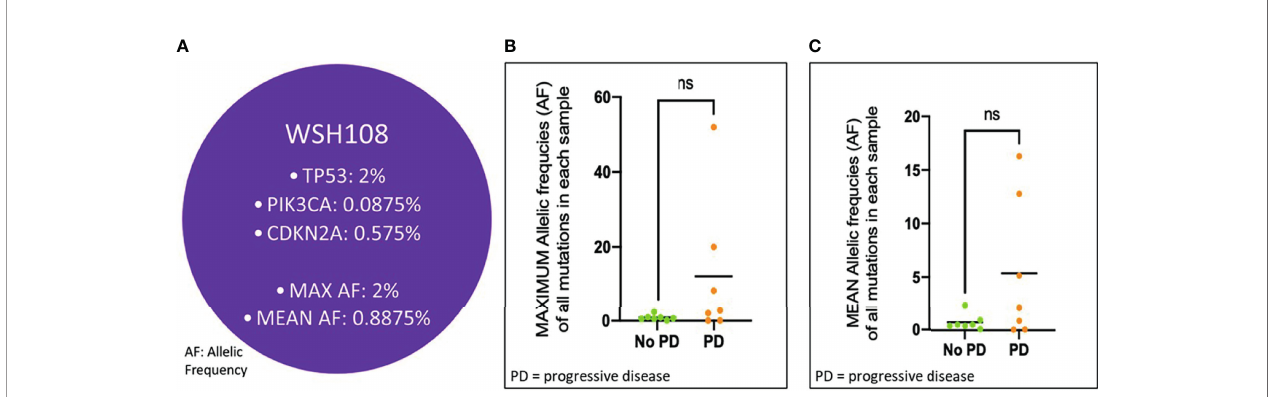
FIGURE 5 | Mean and Max Allelic Frequency in Patients at CRT initiation who Cleared ctDNA, Strati fi ed by Progression. (A) Schematic representation of a patient ’ s (WSH108) pre-CRT sample. Allelic frequency (AF) for each mutation detected in the sample was used for determining maximum and mean AF values. Each of these values across patients who progressed vs. did not progress were compared in the cohort of patients clearing ctDNA using a Student ’ s t-test, as depicted in (B, C) ns, not signi